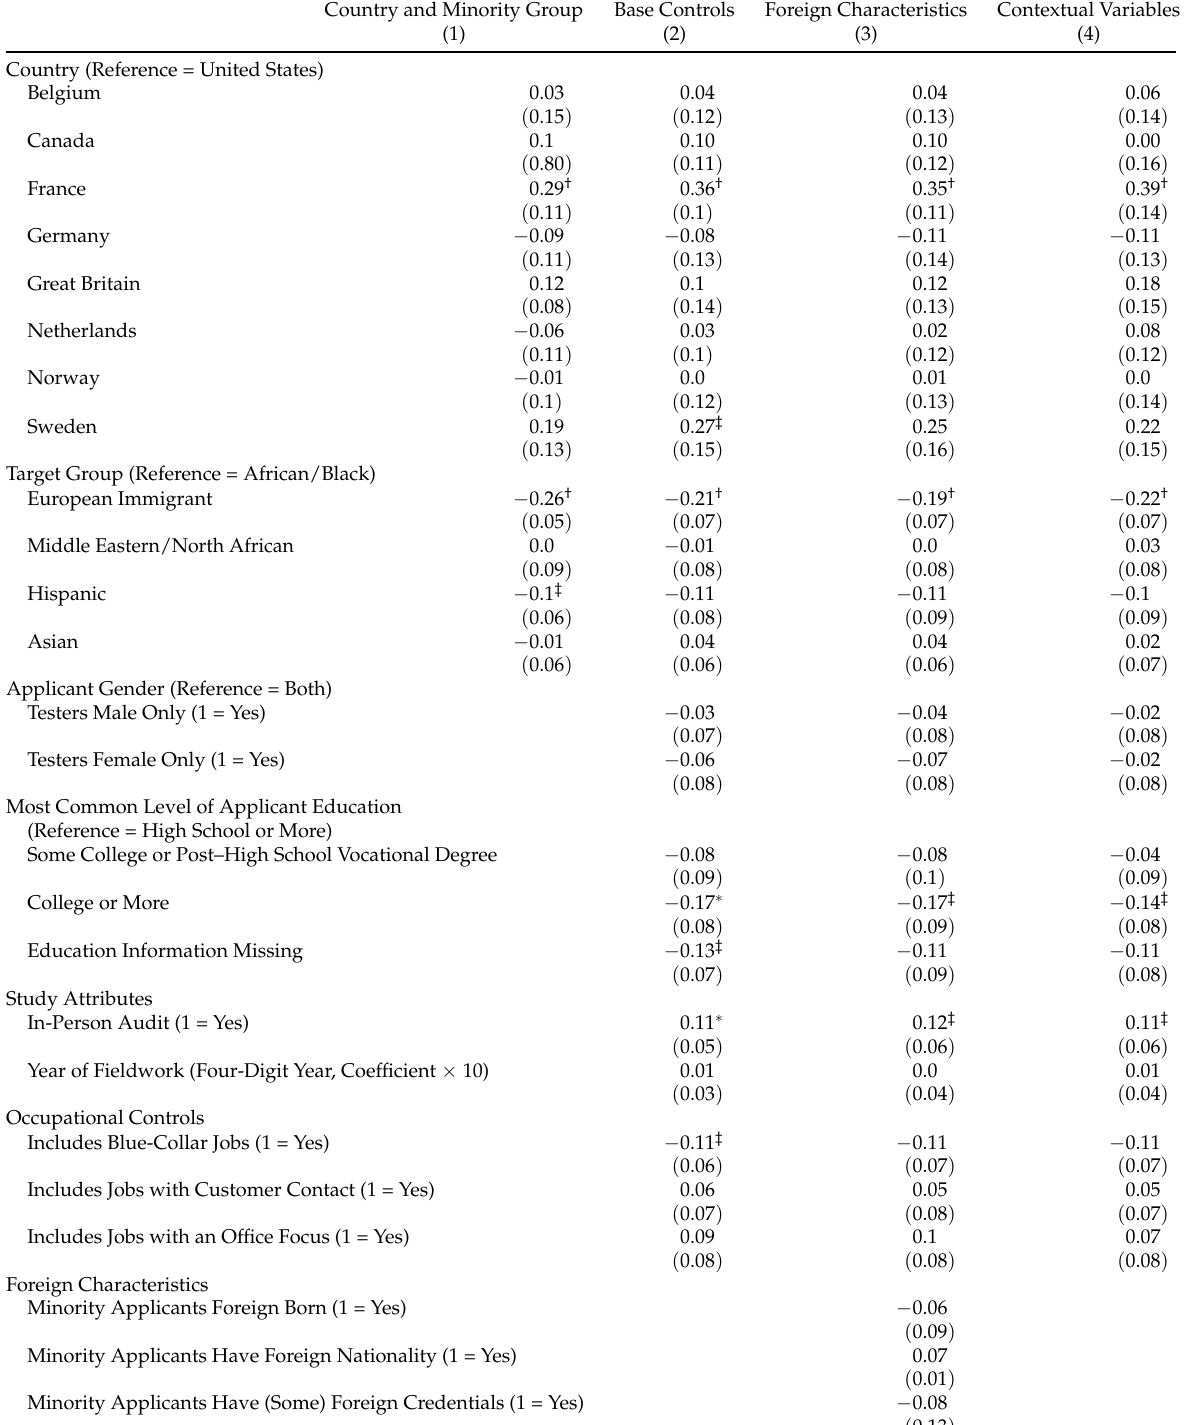
Table 3: Meta-regression estimates of log discrimination ratio on country, minority, and